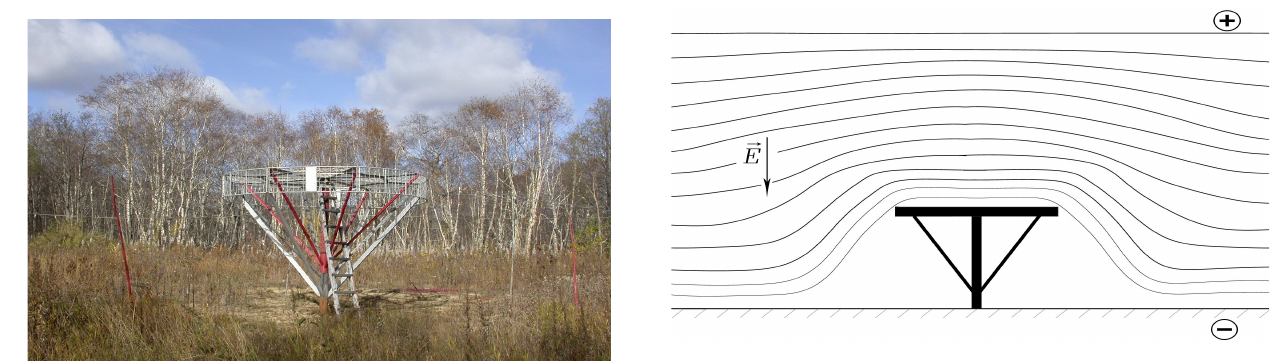
Fig. 2. Leveled surfaces of electric field intensity within the area of sensor installation Fig. 1. “Pole-2” instrument setup at observatory test ground.